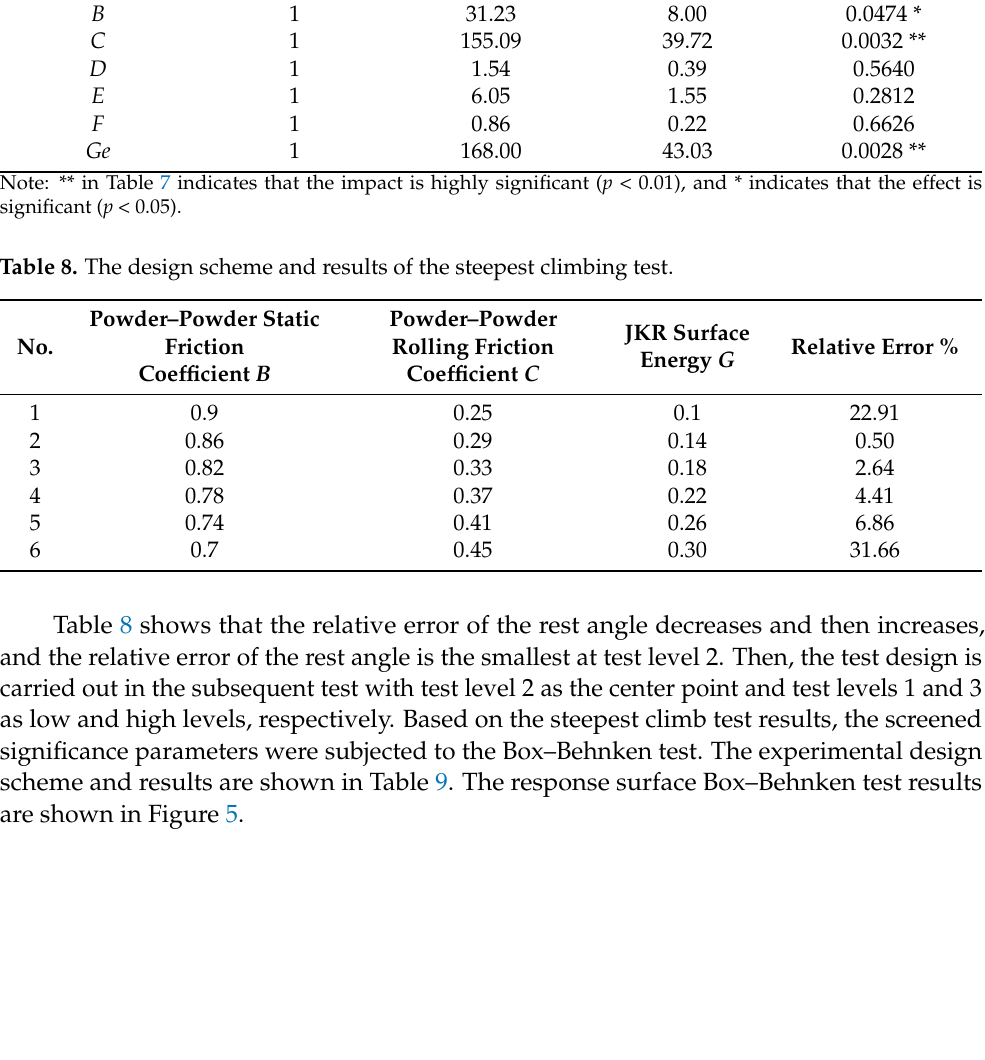
Table 7. Significance analysis of Plackett–Burman test parameters. Parameters DF